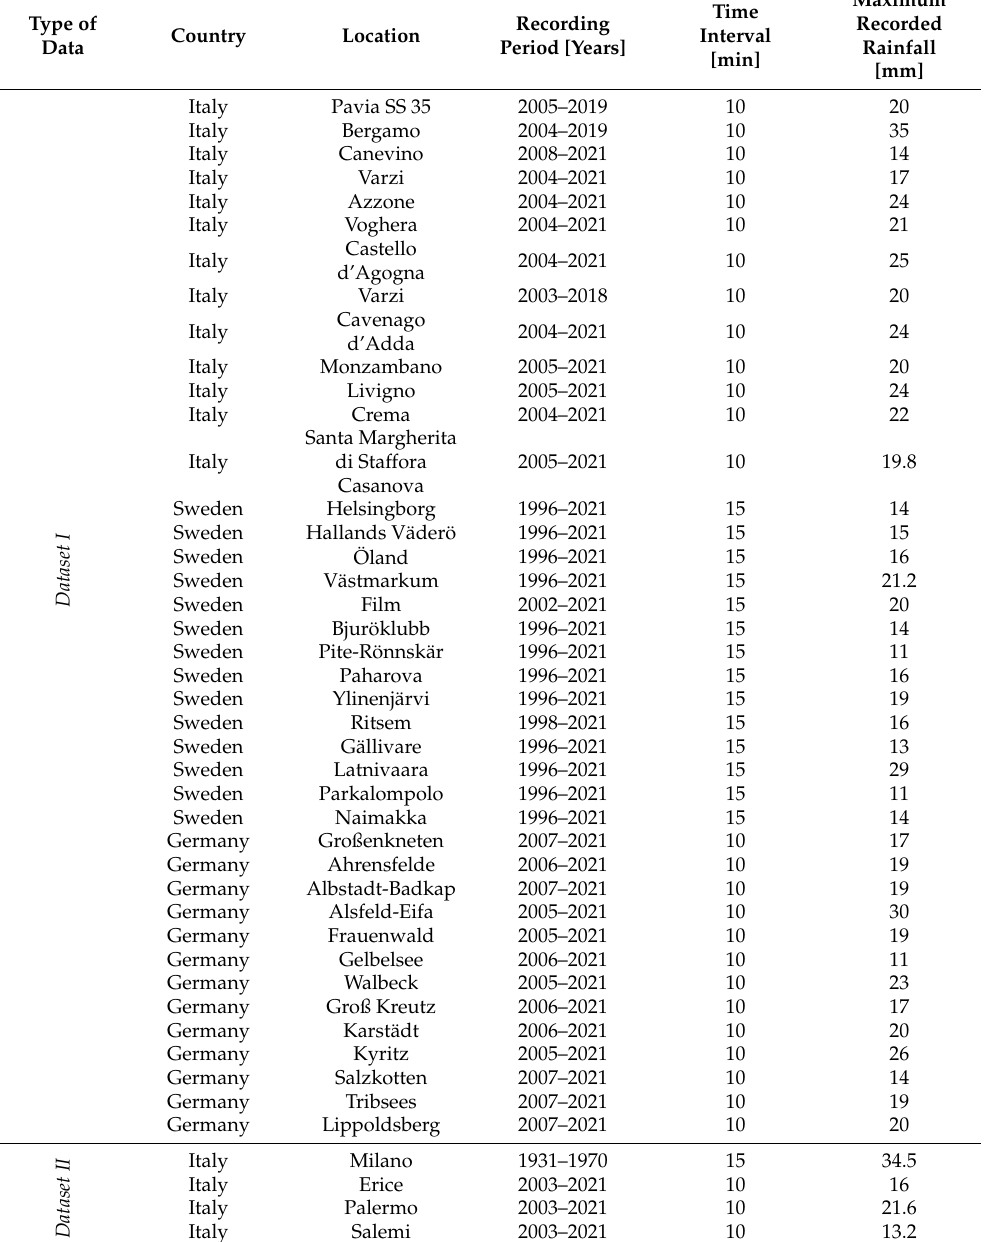
Table 1. Main characteristics of rain gauge stations used in this study. Type of